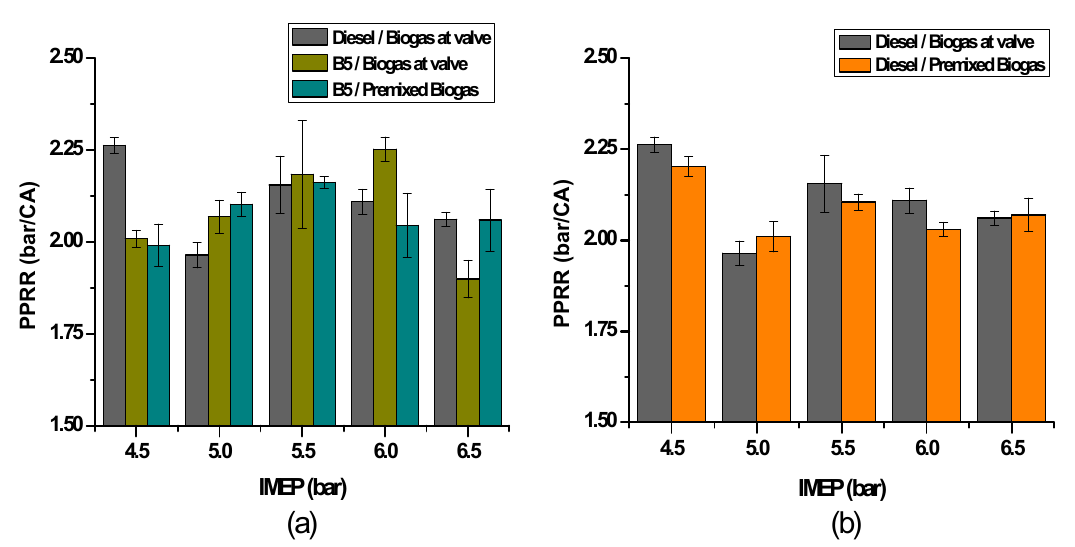
Figure 9. Variation of peak pressure rise rate for ( a ) B5/biogas RCCI in a premixed and injection at the valve and ( b ) diesel/biogas in a premixed and port injection at the valve.